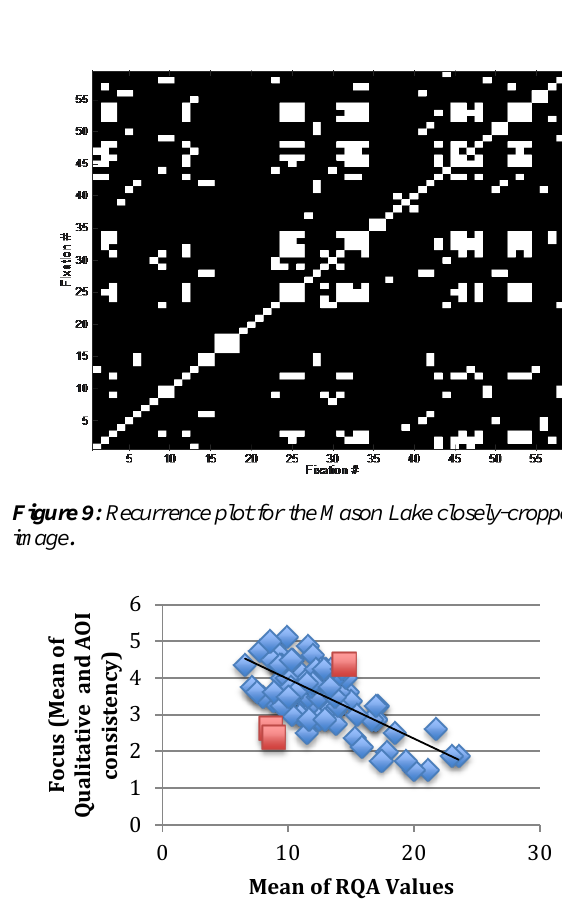
Figure 10 : Mean of the qualitative and quantitative values for attentional focus for the test images used in Farnand (2013) plotted relative to a weighted average of the recurrence and determinism values. The squares represent the Paint Girl and Stained Glass full scenes and the closely-cropped rendition of the Mason Lake scene.